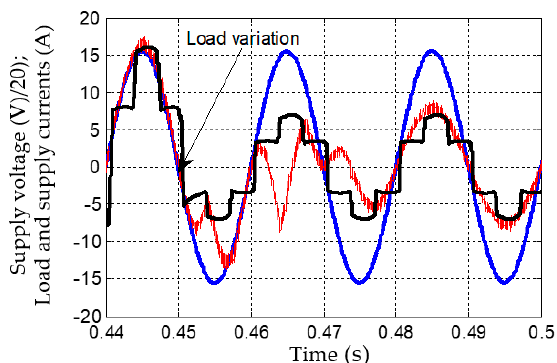
Figure 15. Waveforms of load current (in black), supply voltage (in blue) and supply current (in red) when a step variation of the load occurs.